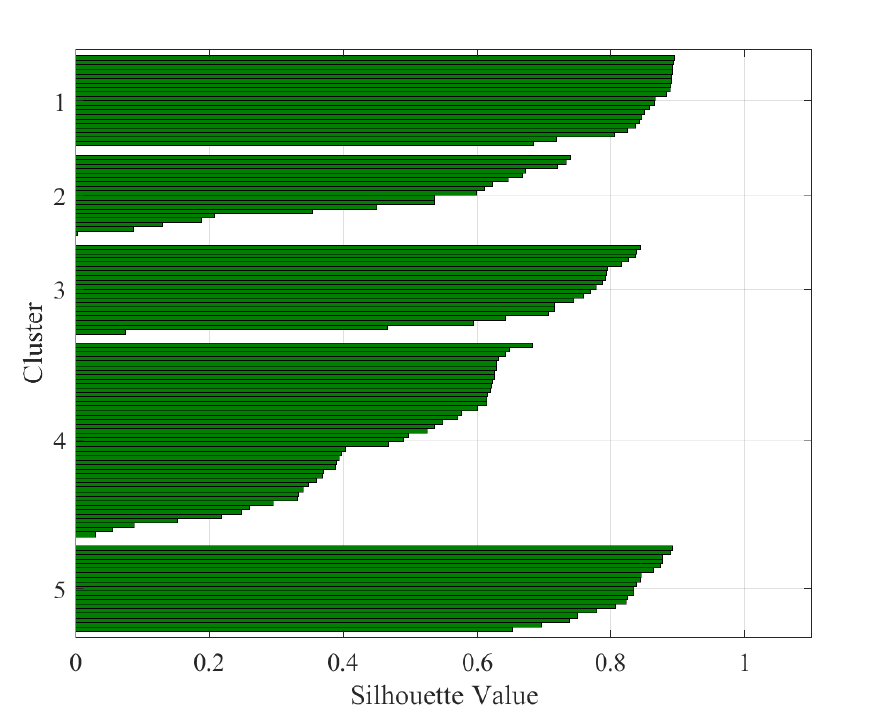
Figure 15. Silhouette plot of clustered stator voltage harmonics data with k = 5.